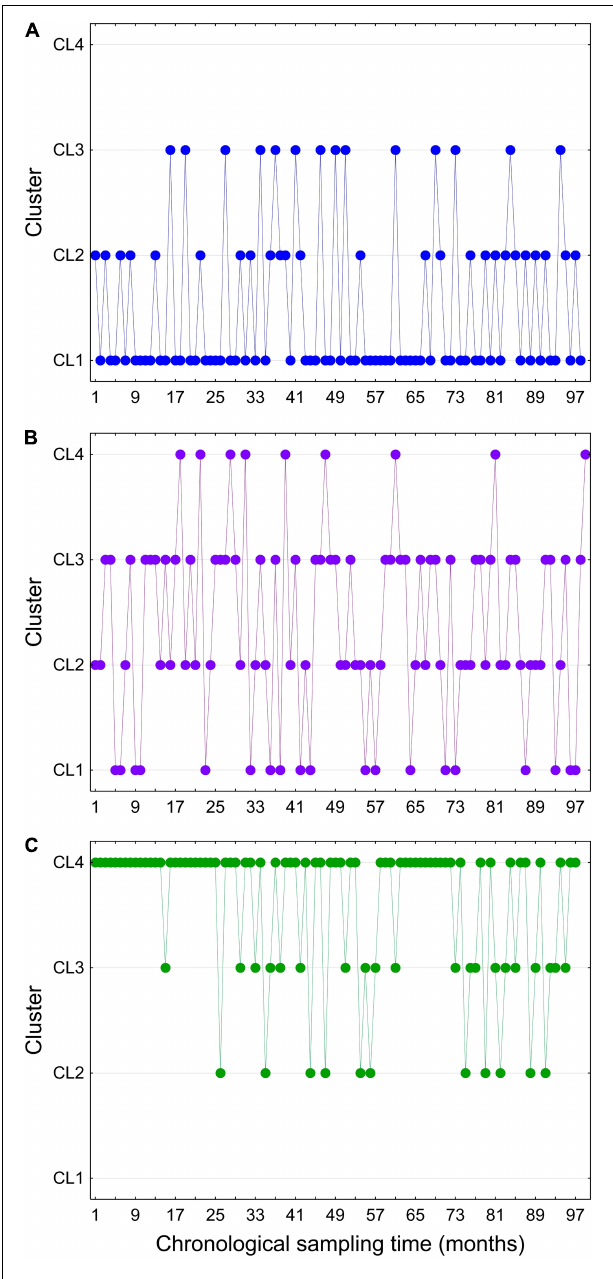
FIGURE 2 | Temporal changes in the state of environmental conditions (expressed as switching between different clusters) at sites typical of the open sea (A) , coastal sea (B) and transitional/estuarine waters (C) .